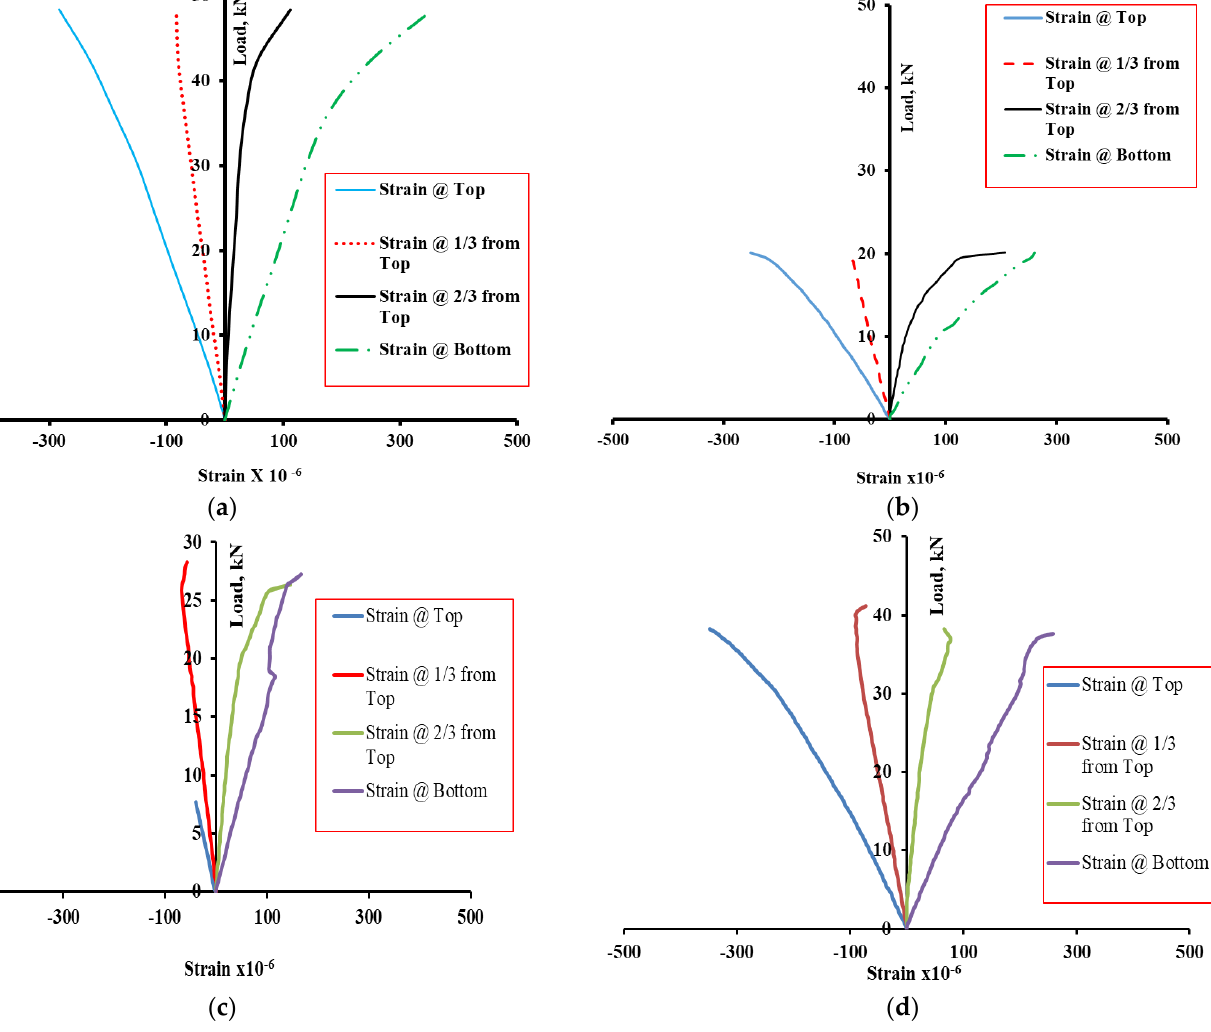
Figure 10. Load – strain curve: ( a ) beam A20, ( b ) beam B20, ( c) D25, and ( d ) D50. Figure 10. Load–strain curve: ( a ) beam A20, ( b ) beam B20, ( c) D25, and ( d ) D50. The strain diagram across the depth of NC-UHPC hybrid beams obtained from mea- sured values of strains at four locations are shown in Figure 11a,b for the beam specimens A20 and B20 and Figure 11c,d for the beam specimens D25 and D50. The variation in strains for five increasing load levels for specimen A20 and four load levels for other specimens are shown in the figures. These load levels represent strains at lower levels of load and close to failure. For all specimens, the compressive strains for lower load levels are almost linear. For specimen B20, the tensile strains follow the linear path without any divergence. However, for specimens A20, D25 and D50, the slope of the line change below the neutral axis at the NC-UHPC interface at the load level equal to 75% of P U and higher level. This divergence can be attributed to a possible slip at the interface. It can also be seen